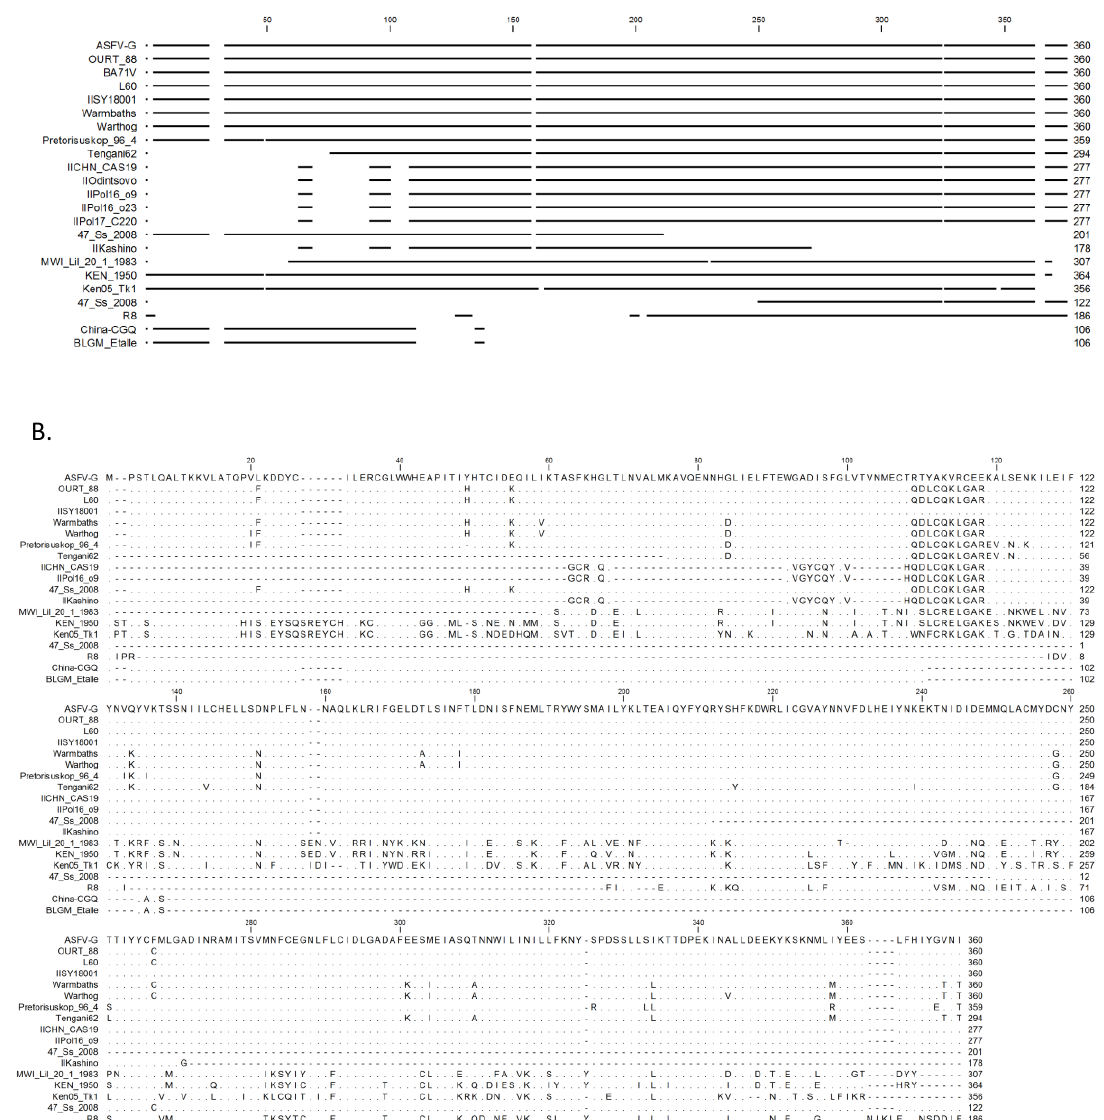
Figure 2. Multiple sequence alignment of the indicated ASFV isolates of viral protein MGF360-1L. ( A ) An overview of matching areas of the protein. ( B ) Amino acid level alignment with matching residues are represented as dots and missing residues as dashes. ASFV, African swine fever virus.